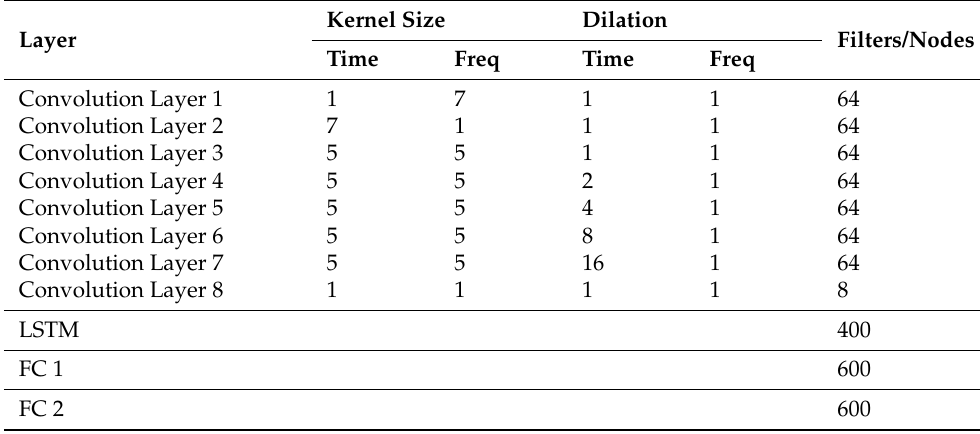
Table 1. Parameters of voice filter network.